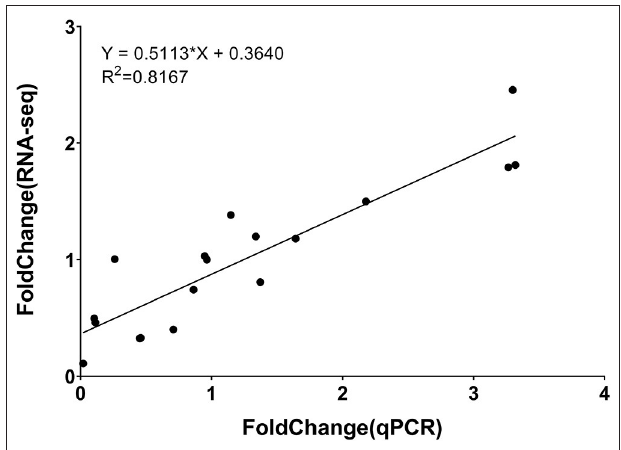
FIGURE 10 | Correlation between results of RT-qPCR and RNA-seq for select